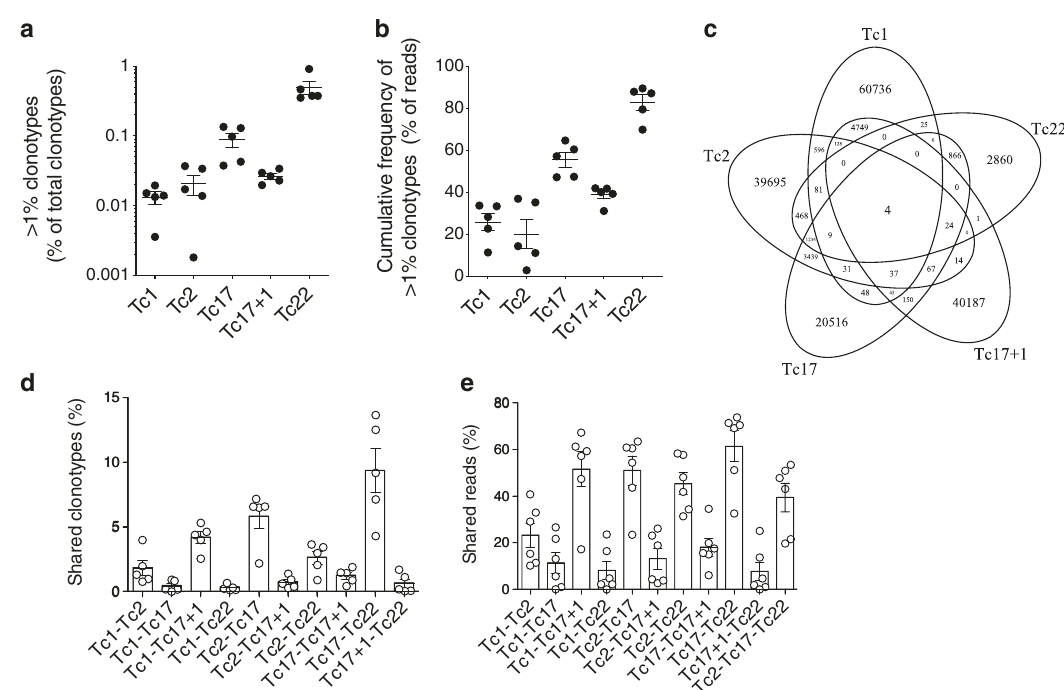
Fig. 5 Cytotoxic and helper CD8 + T-cell subsets differ in their TCR repertoire. a Contribution of clonotypes present at frequencies >1% of reads to the total clonotype repertoire ( n = 5), mean ± SEM. b Cumulative contributions of clonotypes present at frequencies >1% to the total reads in all fi ve donors. Mean± SEM. c Venn diagram showing a representative overlap of clonotypes of different Tc-cell subsets. d , e Bar diagram showing the percentage of shared clonotypes ( d ) and shared reads ( e ) of indicated subsets in all fi ve donors. Mean ±